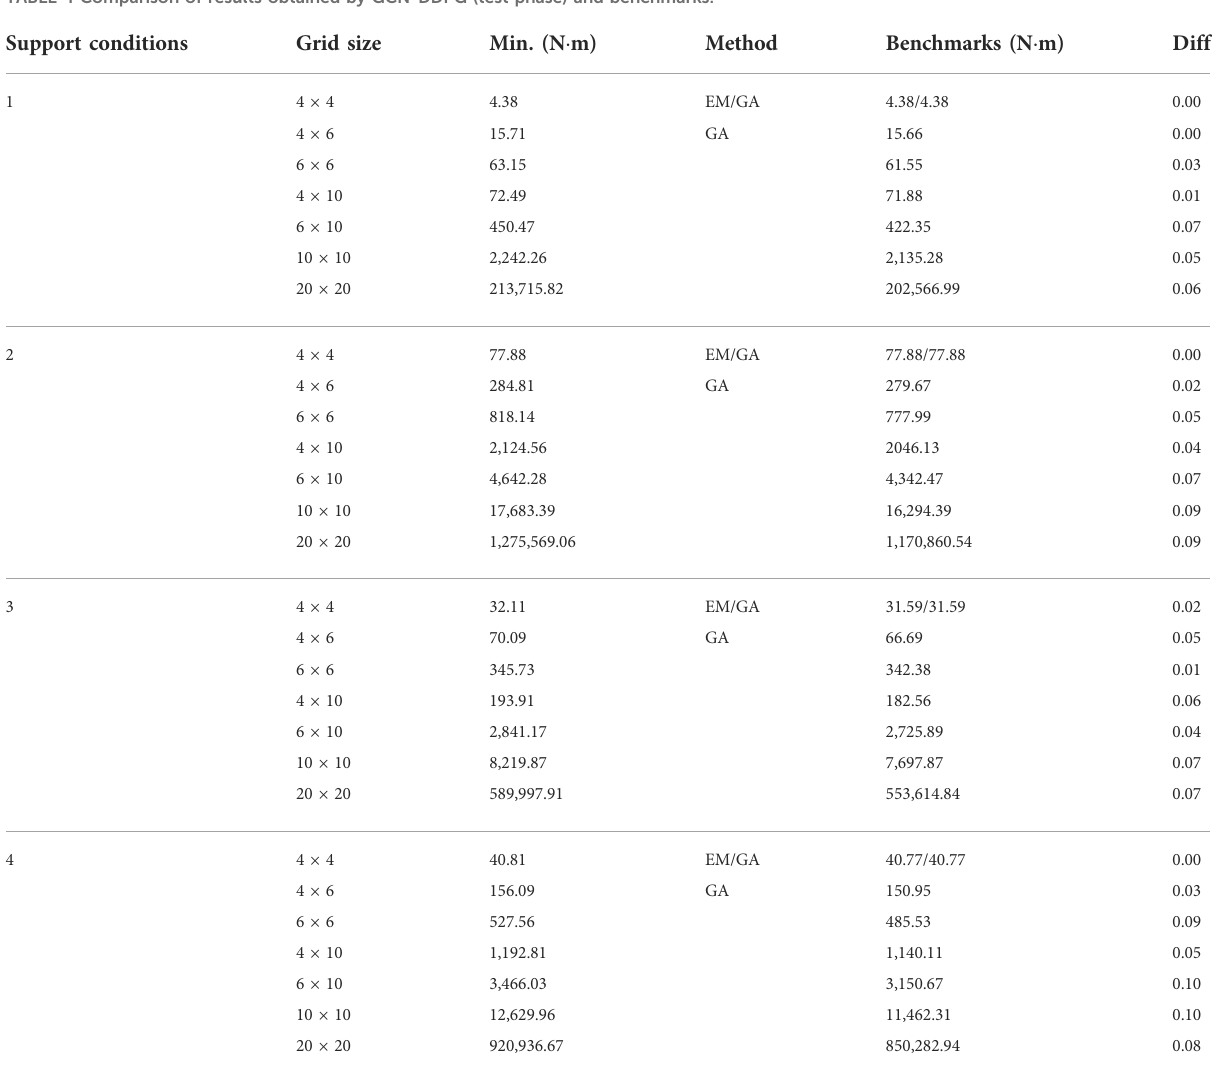
TABLE 4 Comparison of results obtained by GCN-DDPG (test phase) and benchmarks. Support